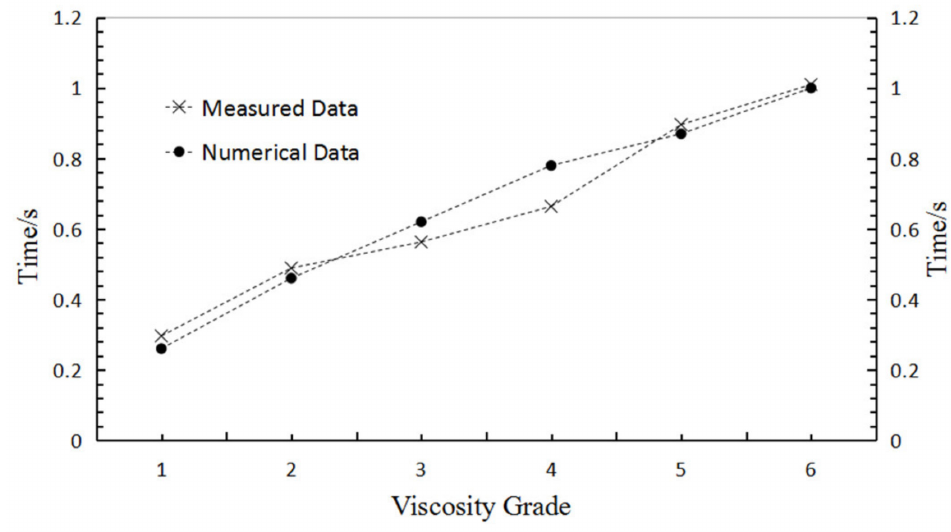
Figure 6. The contrast curves between measured data and numerical